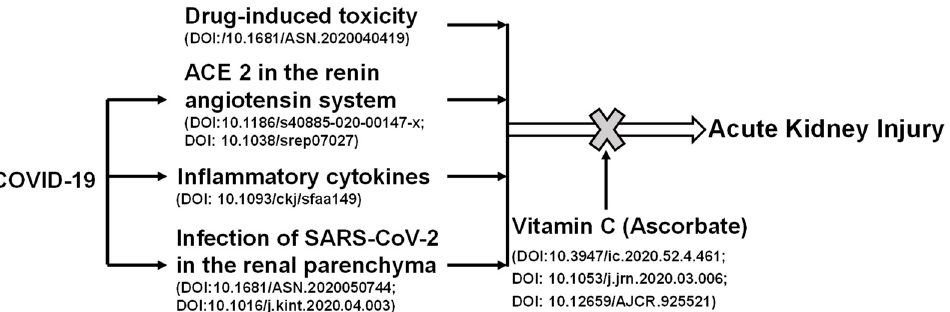
Figure 2. The positive role of vitamin C in acute kidney injury induced by chemical toxicity or COVID-19. Renal toxic chemicals and development of COVID-19 can cause acute kidney injury. SARS-CoV-2 viral particles enter cells via its interacting protein angiotensin converting enzyme 2 (ACE2). Viral infections lead to cytokine storm and cause hemodynamic changes through the high expression of ACE2. Vitamin C acts to reduce oxidative stresses and repair damage, and in turn, attenuates acute kidney injury. Vitamin C can reduce the expression of ACE2, which hinders the entry of virus into cells, and stabilizes blood pressure.